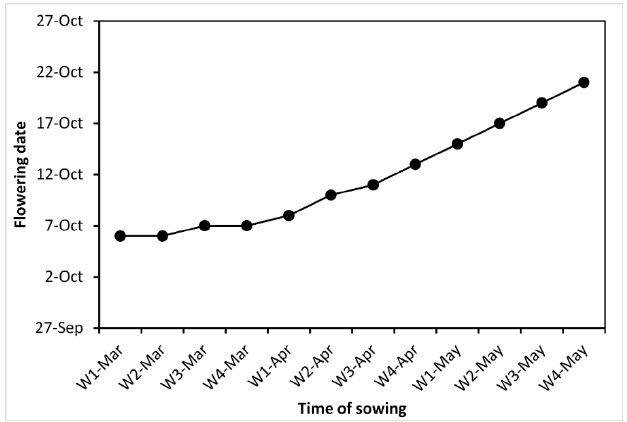
Figure 10. Flowering time of a dual-purpose wheat sown at different times (from the first week of March to the last week of May).